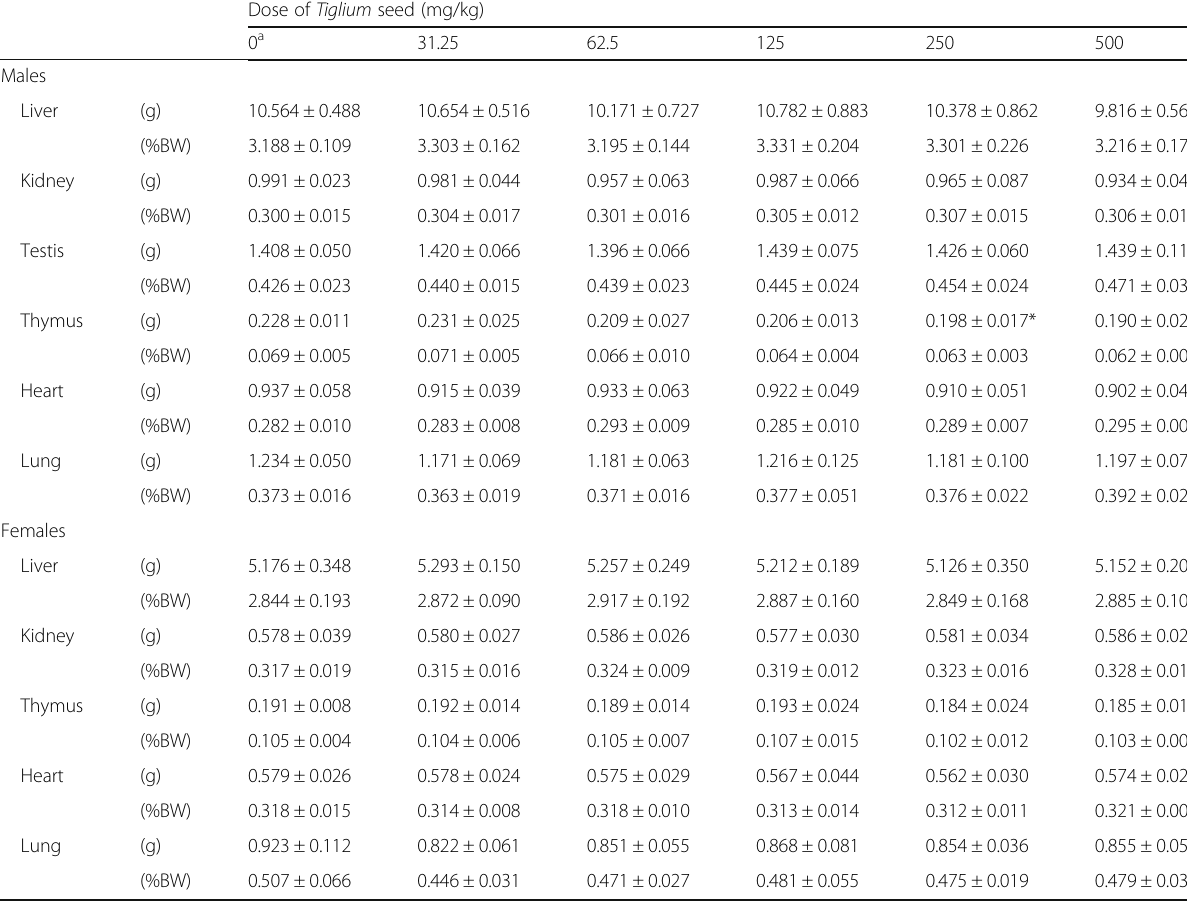
Table 3 Organ weights of male and female F344 rats orally administered with Tiglium seed extract for 13